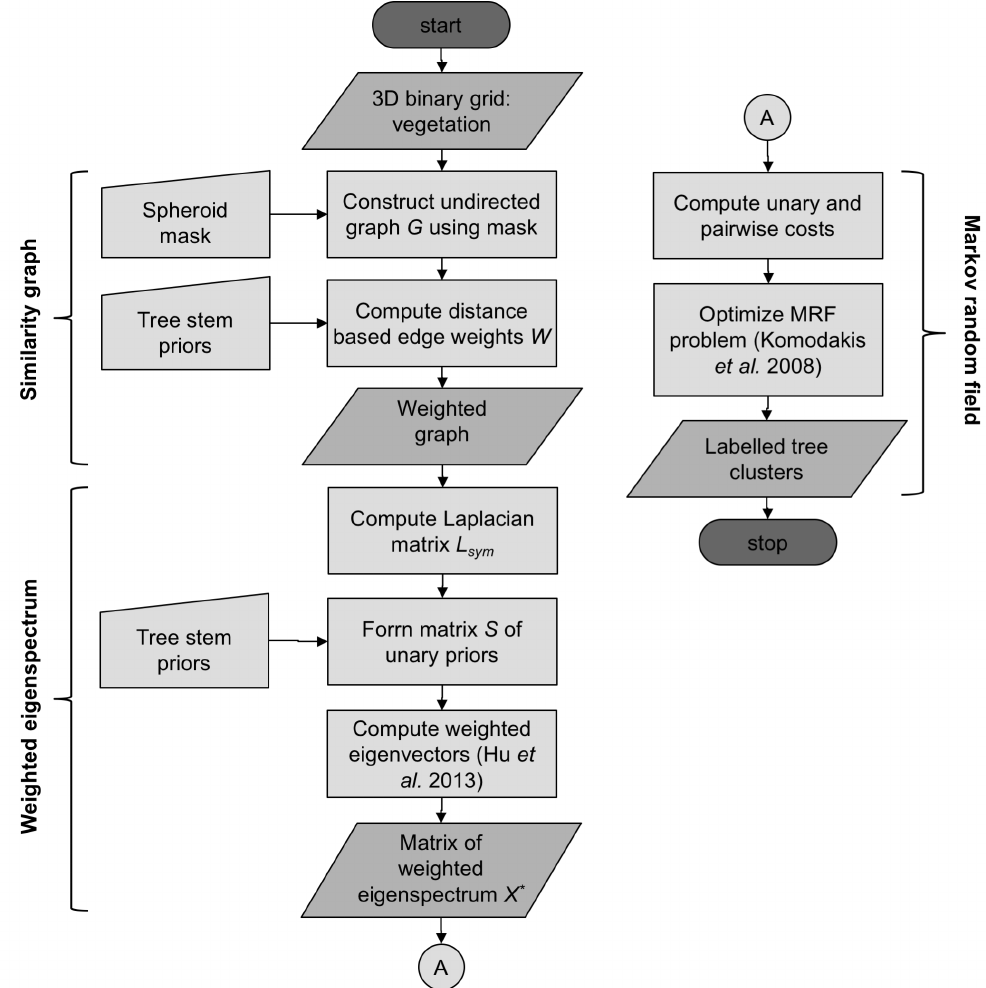
Figure 3. Flowchart providing an overview on the single steps of constrained spectral